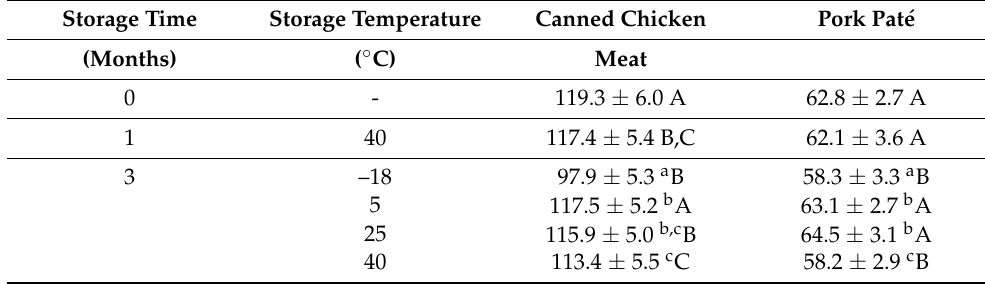
Table 4. Results of hardness (N) of canned chicken meat and pork p â t é dependent on various temperature regimens ( − 18 ◦ C; 5 ◦ C; 25 ◦ C; and 40 ◦ C) and storage time (months). The results are presented as means ± standard deviations ( n = 27)